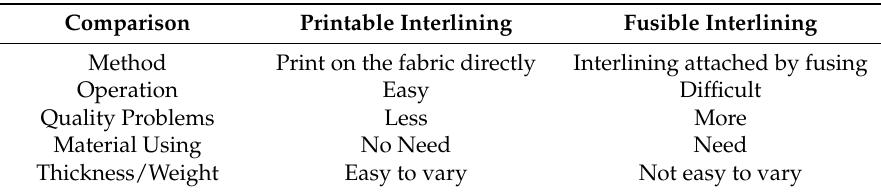
Table 6. Comparison of printable interlining and fusible